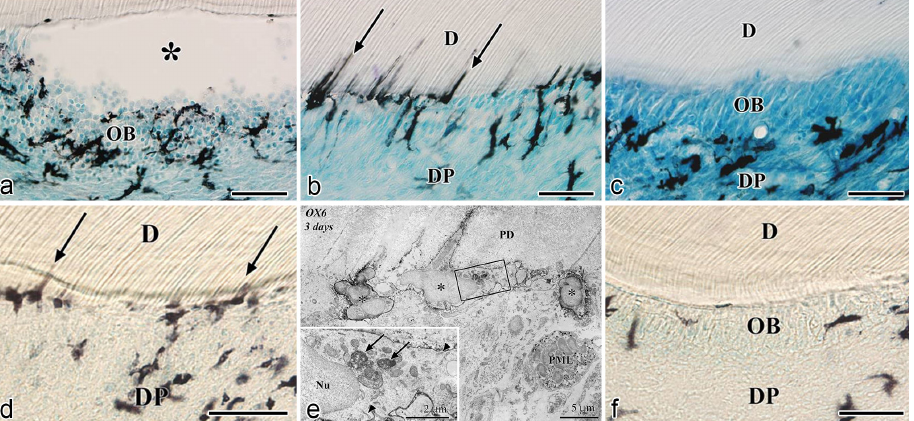
Figure 3. Relationship between DCs and odontoblasts or newly differentiated odontoblast-like cells after noninfected exogenous injuries in rat molars (cited from Ohshima et al. [44], with permission fromWilley and Nakakura-Ohshima et al. [45], with permission from Oxford University Press). ( a – c ) Cavity preparation model. ( d – f ) Tooth replantation model. ( a – f ) Immunohistochemistry with OX6 antibody. ( e ) TEM view. ( a ) Exudative lesions appear right after the initial injury beneath the injury site. OX6 + cells move inward from the pulp-dentin border and are relocated beneath the exudative lesions. ( b ) Twelve hours after cavity preparation, the number of OX6 + cells increase under the afflicted area (arrows). The exudative lesions disappear from 12 h to 1 day after the injury. ( c ) On day 3, the afflicted area of the pulp completely recovers. OX6 + cells are located exclusively beneath the odontoblast layer. ( d ) Three days after the tooth replantation, DCs located at the pulp-dentin border consistently express OX6 (arrows). ( e ) The ultrastructure of OX6 + cells on day 3 presents tubulovesicular structures and multivesicular bodies in their cytoplasm. An intense immunoreaction is observed in their cell membranes (arrows in inset). ( f ) OX6 + cells are observed in between or beneath the newly-differentiated odontoblast-like cells. D dentin, DP dental pulp, OB odontoblasts, PD predentin, Bar = 50 µ m ( a – d , f ), 5 µ m ( e ), 2 µ m (inset). * exudative